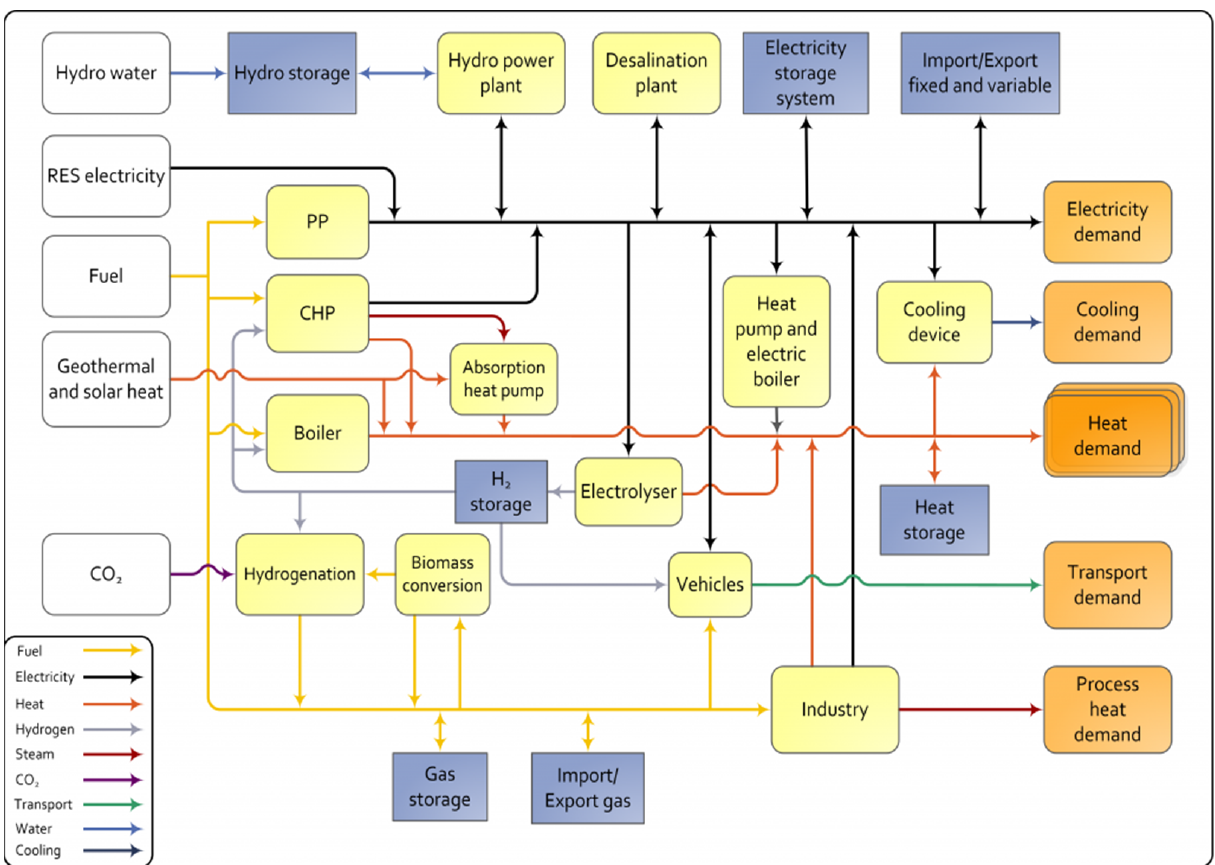
Figure 1. The input–output energy flow of frame diagram for EnergyPLAN software [ 56 ] .